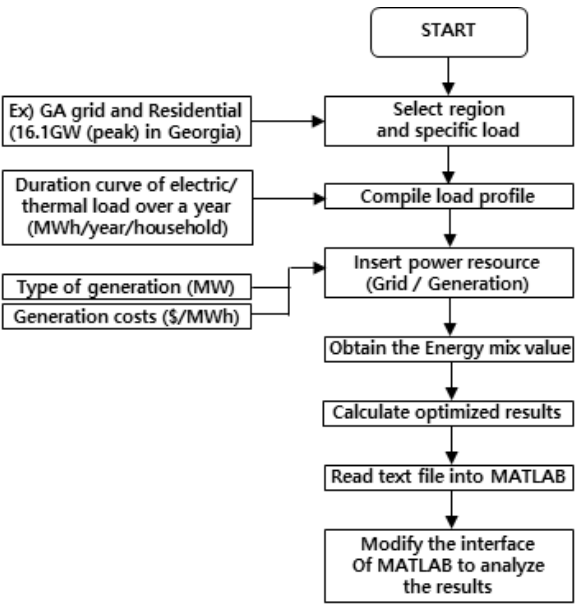
Figure 6. Traditional generation allocation